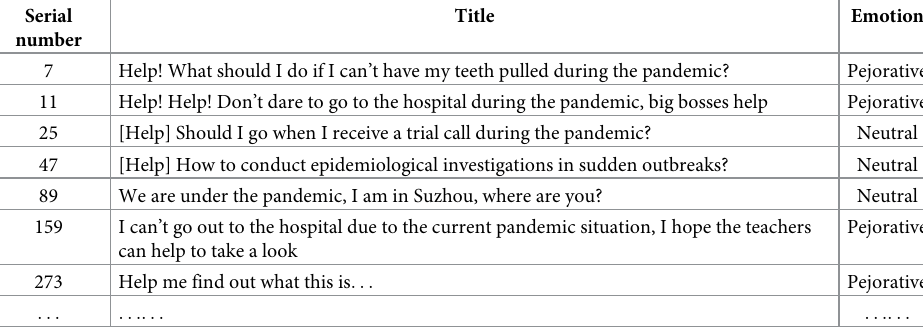
Table 3. Cases of user participation in the “Lilac Forum” during the pandemic.